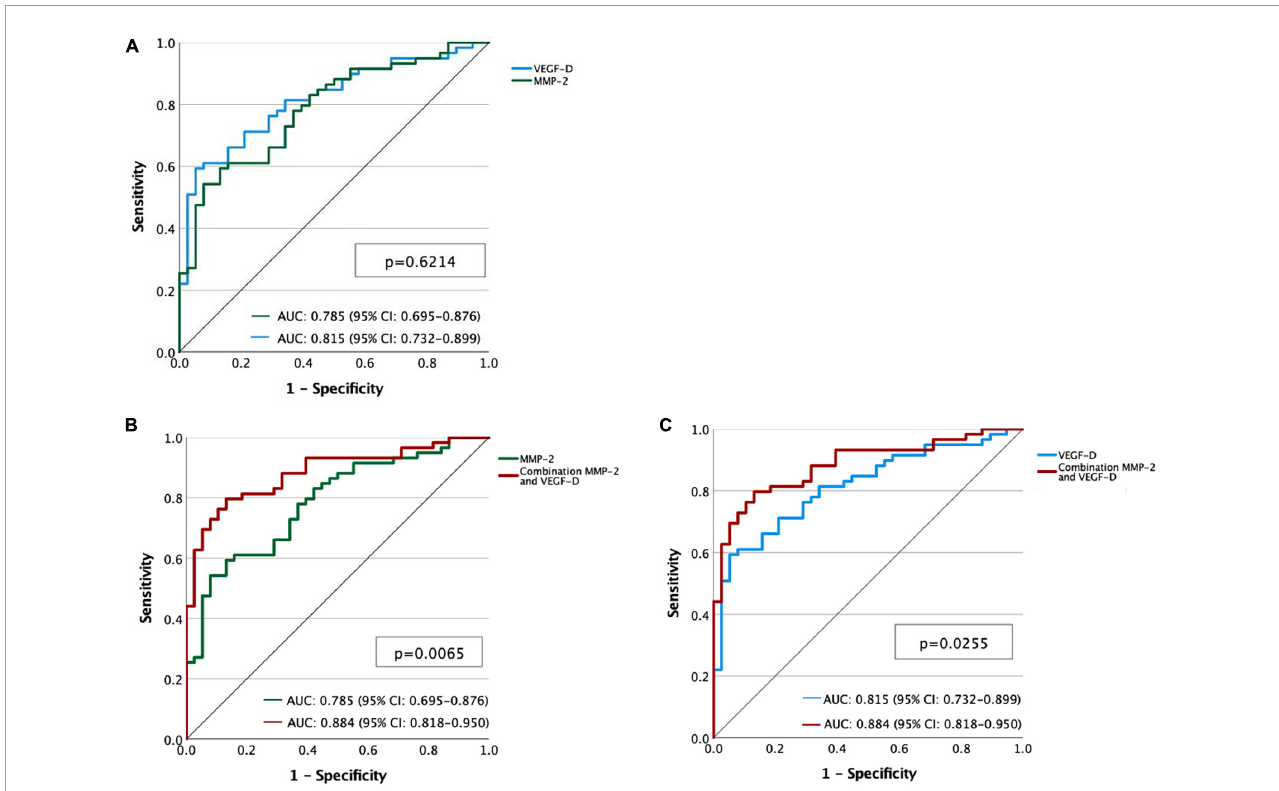
FIGURE4 (A) Receiver operating characteristic (ROC) curves for metalloproteinase-2 (MMP-2) (green line) and vascular endothelial growth factor-D (VEGF-D) (blue line). (B) ROC curves of MMP-2 (green line) and the combination of MMP-2 and VEGF-D (red line). (C) ROC curves of VEGF-D (blue line) and the combination of MMP-2 and VEGF-D (red